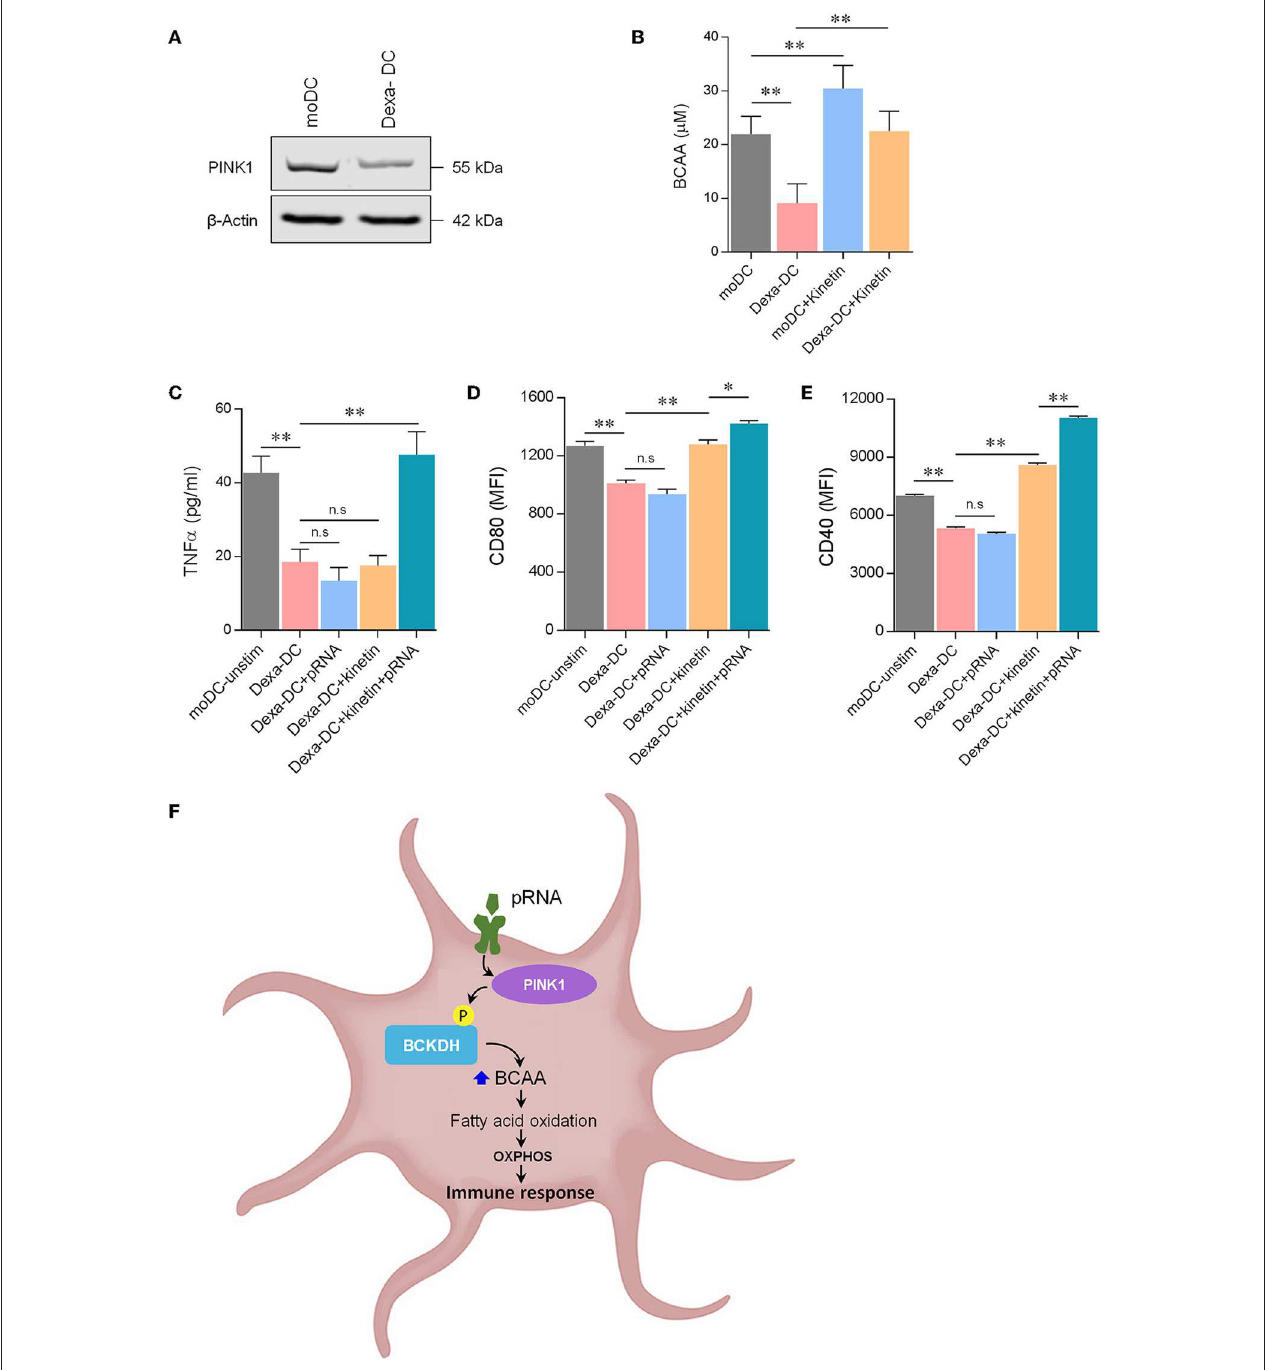
FIGURE 6 | Kinetin primes immunosuppressive DC for maturation. (A) Expression of PINK1 in DCs was determined by western blotting. β -actin was used as a loading control. (B) Total BCAA concentrations were measured in DCs, stimulated for 12h with pRNA in the presence or absence of 20 µ M kinetin, using a colorimetric assay kit. Data represents Mean ± SEM of three independent experiments performed in triplicate. ** p < 0.01 (Student’s t -test). (C) TNF α levels on protein level were measured in the supernatant of the DCs stimulated for 12h with pRNA in the presence or absence of 20 µ M kinetin. Data represents mean ± SEM of three independent experiments performed in triplicate. ** p < 0.01 (Student’s t -test). (D) Mean fluorescence intensity of CD80 in DCs stimulated for 12h with pRNA in the presence or absence of 20 µ M kinetin. Data represents mean ± SEM of three independent experiments performed in triplicate. * p < 0.05; ** p < 0.01 (Student’s t -test). (E) Mean fluorescence intensity of CD40 in DCs stimulated for 12h with pRNA in the presence or absence of 20 µ M kinetin. Data represents mean ± SEM of three independent experiments performed in triplicate. ** p < 0.01 (Student’s t -test). (F) Mechanistic model of OXPHOS-mediated DC activation. Activation of TLR7/8 with pRNA lead to increase in OXPHOS. pRNA stimulation phosphorylates BCKDE1 α in a PINK1-dependent manner. pRNA stimulation increased branched-chain amino acid (BCAA) to promote FAO. Increased FAO and OXPHOS were required for DC activation.